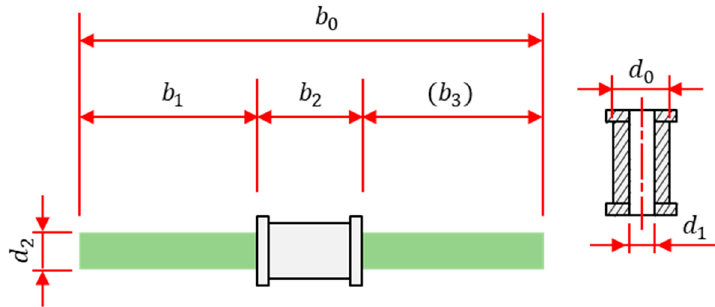
Figure 8. Experimental data expressed as points and FEA results expressed as dotted lines.